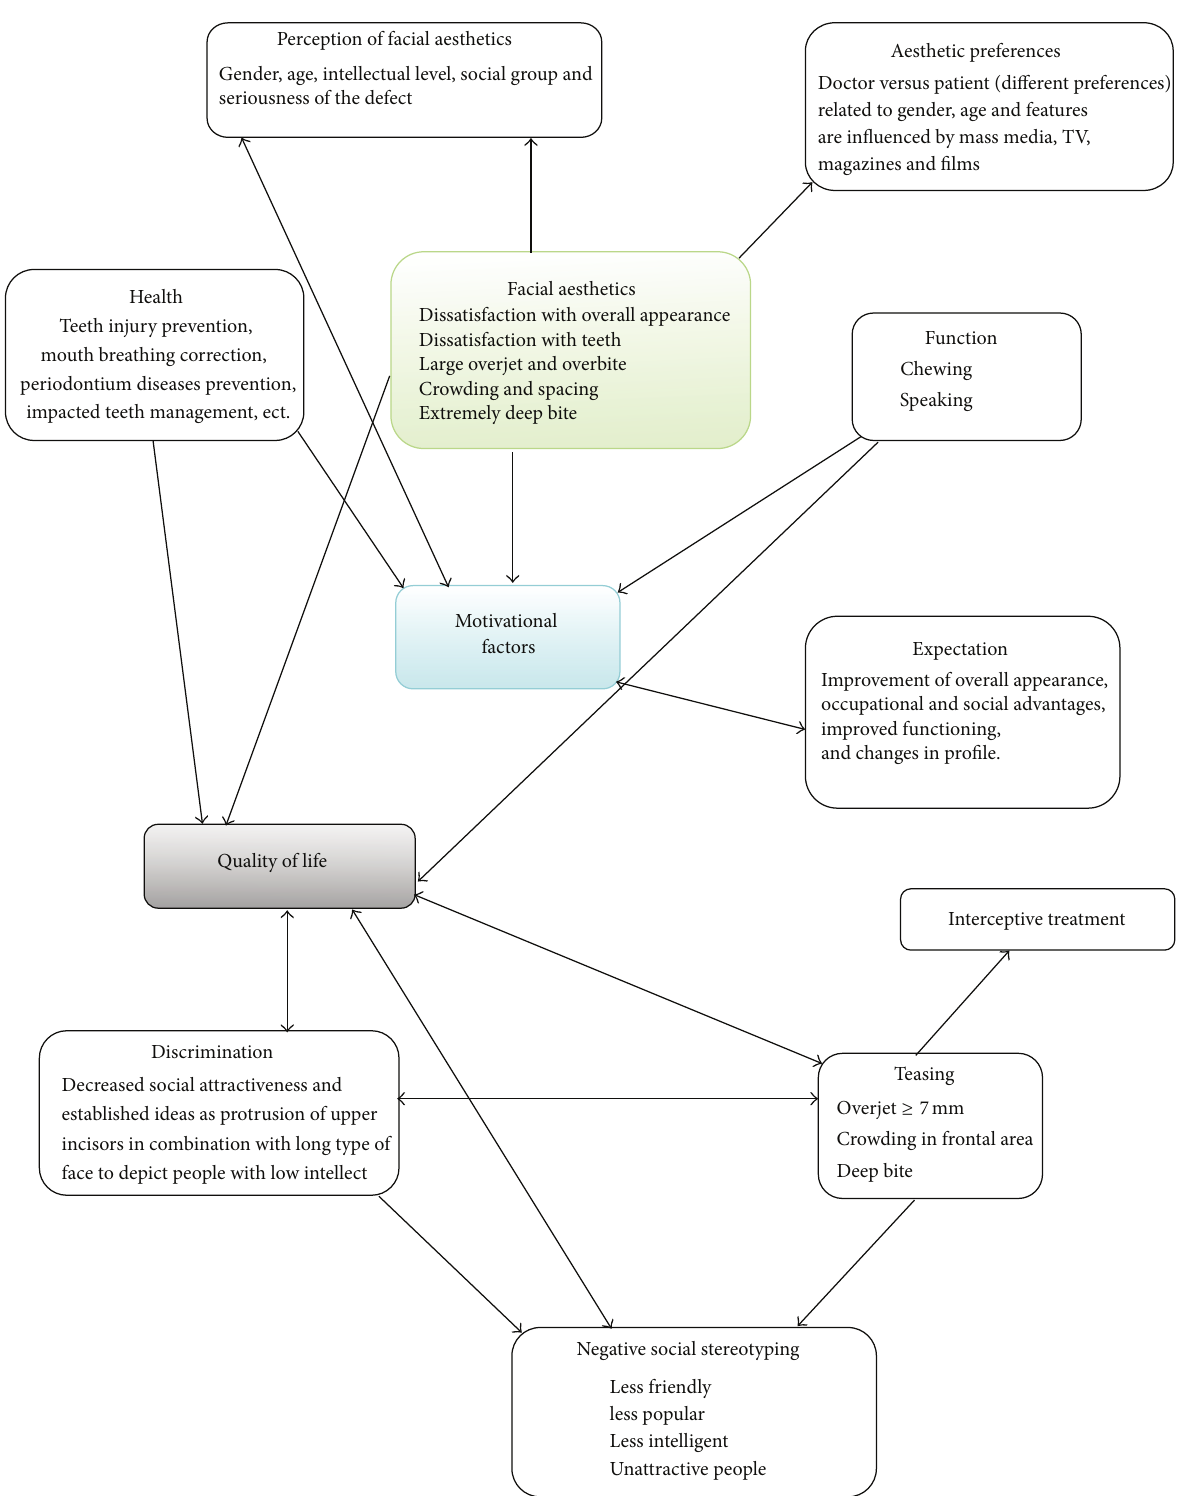
Figure 2: Impact of facial aesthetics on quality of